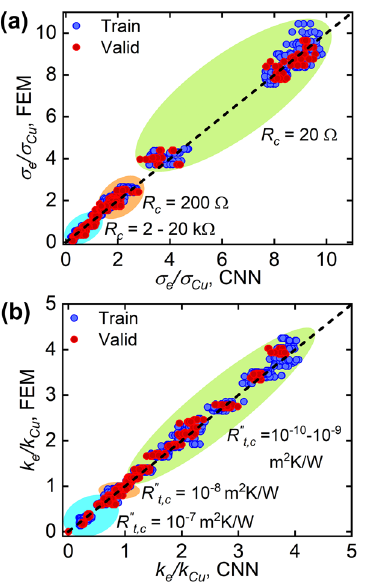
Figure 4. Comparison between CNN approximations and FEM predictions for ( a ) effective electrical conductivities with R 2 Train = 0.991, R 2 Valid = 0.982, and ( b ) effective thermal conductivities with R 2 Train = 0.992, R 2 Valid =